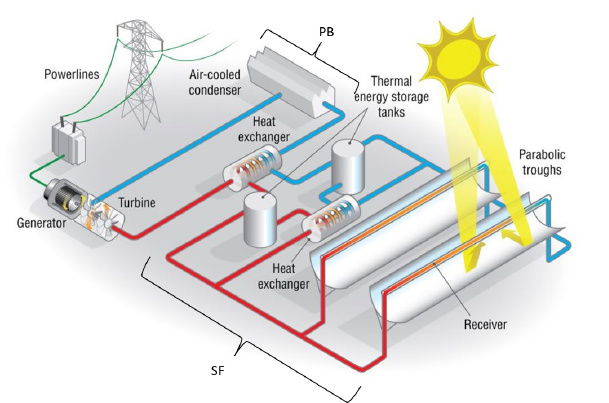
Figure 1. Parabolic-trough solar thermal power plant (PTSTPP) scheme